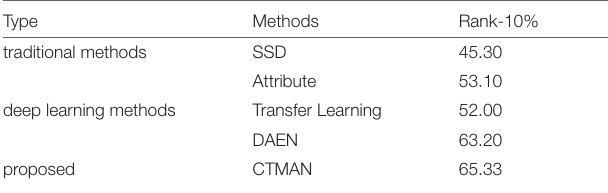
TABLE 8 | Comparison experiment results on S4